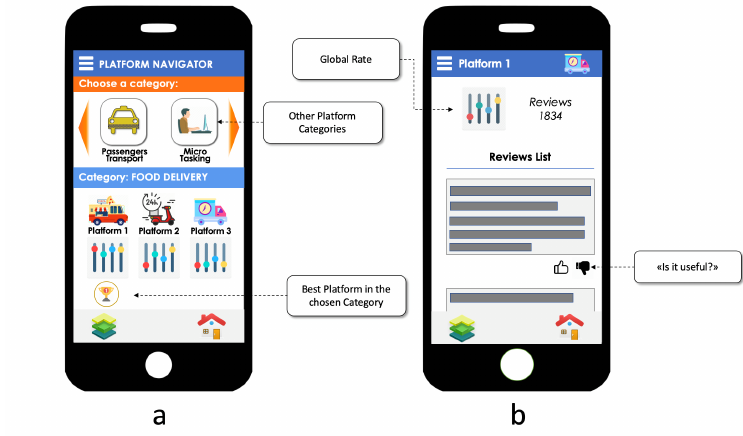
Figure 7. The GigAdvisor Platform Navigator. User can choose the platform ( a ) and explore its reviews ( b